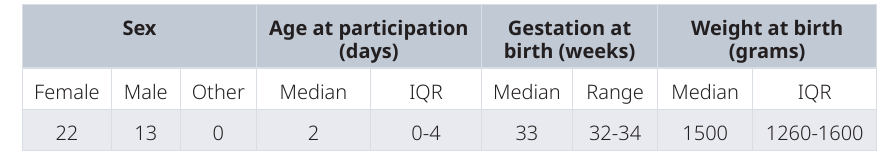
Table 3. Neonate demographic data.